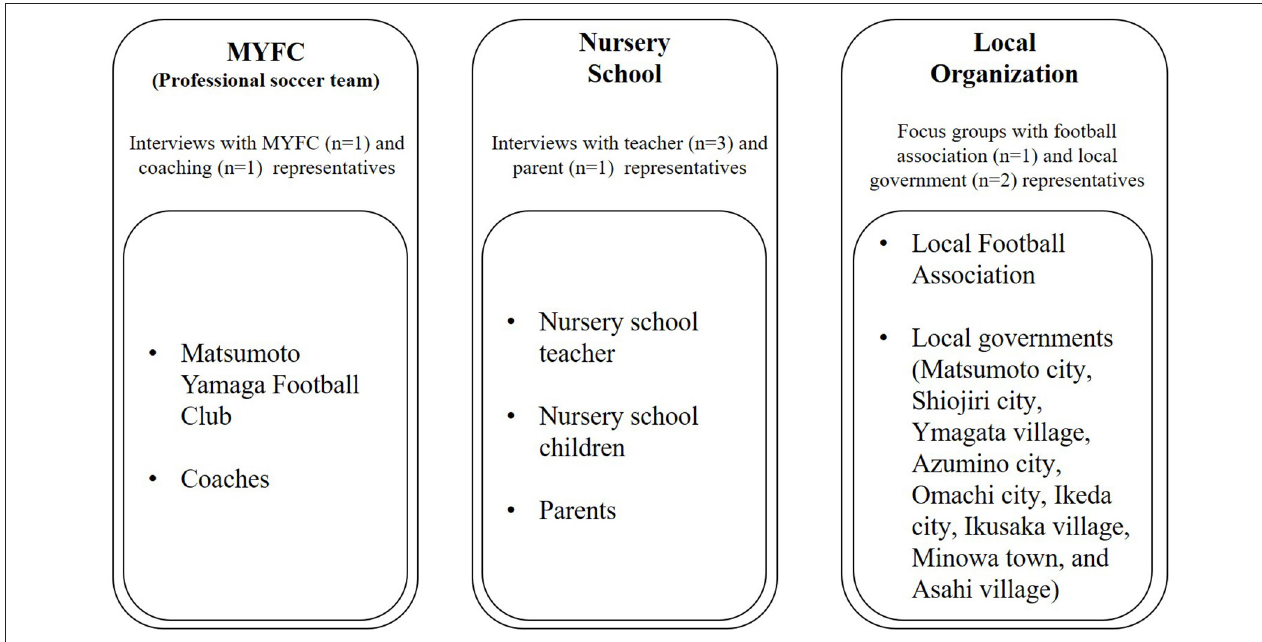
FIGURE 2 | Stakeholder